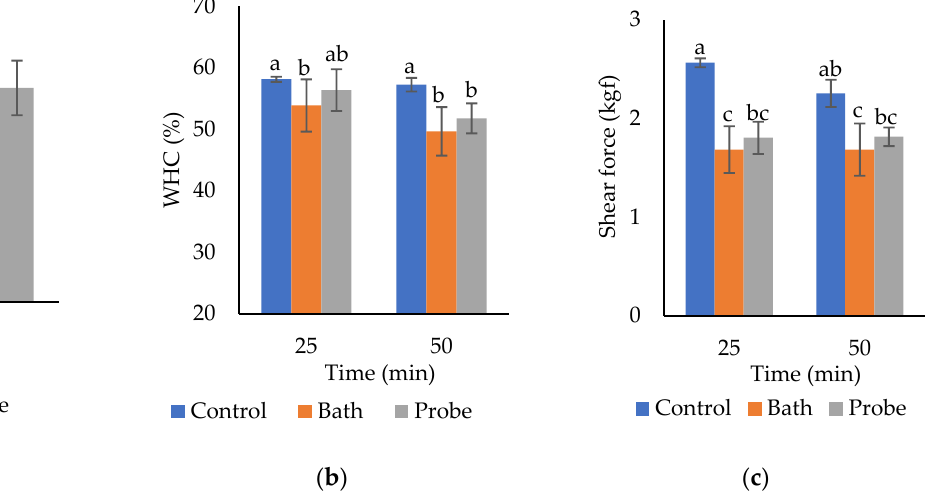
Figure 1. Effect of the combination of HIU system and HIU time factors on pH ( a ), water holding capacity (WHC, %) ( b ), and shear force (kgf) ( c ) of bovine Longissimus lumborum . a,b,c Different letters in the columns within the same graph indicate significant differences between treatments ( p < 0.05).